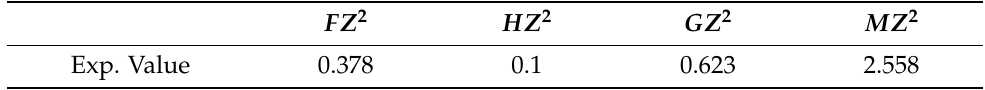
Table 1. Experimental data from Ref. [37].